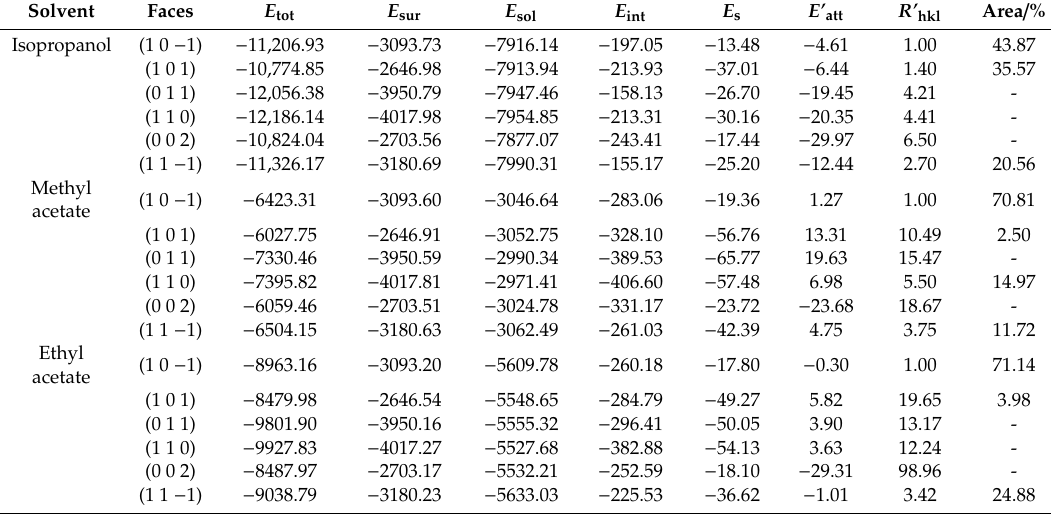
Table 3. Simulated results of the dominant crystal faces in isopropanol, methyl acetate and ethyl acetate 1